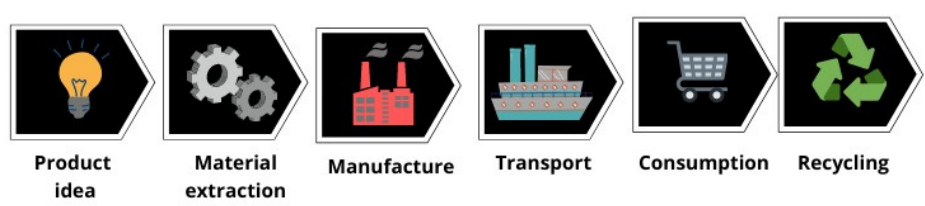
Figure 1. Linear economy.